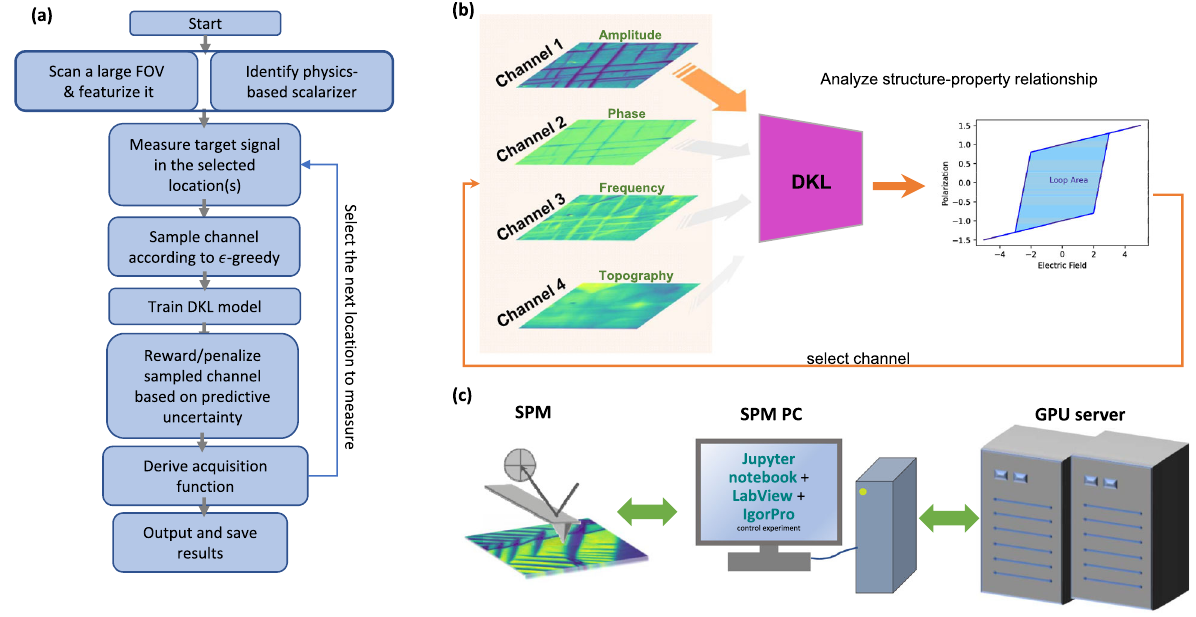
Fig. 2 BEPFM experimental process driven by ensemble DKL. a Ensembel DKL work fl ow. b BEPFM image channels are used to predict a functional property, e.g., polarization loop area or resonance frequency loop area. The image data have four channels: amplitude (Channel 1), phase (Channel 2), resonance frequency (Channel 3), and topography (Channel 4). The goal is to identify the best channel for predicting the functional property. c A schematic showing hardware connected in the work fl ow, including a Cypher SPM, a PC, and a GPU